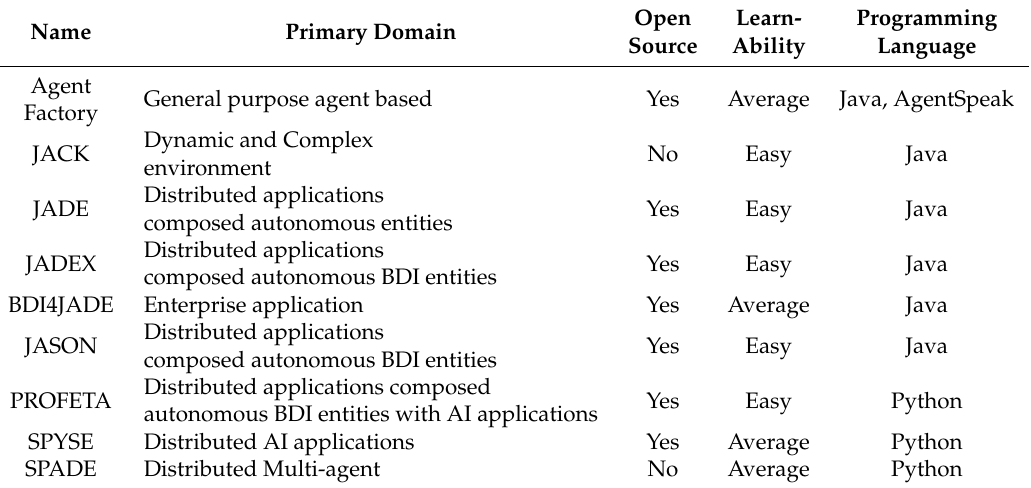
Table 1. Comparison between different beleif–desire–intention (BDI)